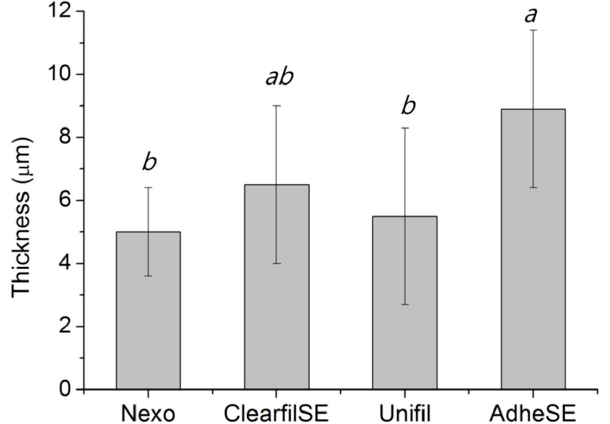
Figure 2. Thickness of bonding agent ( μ m). The same letters mean no significant differences.